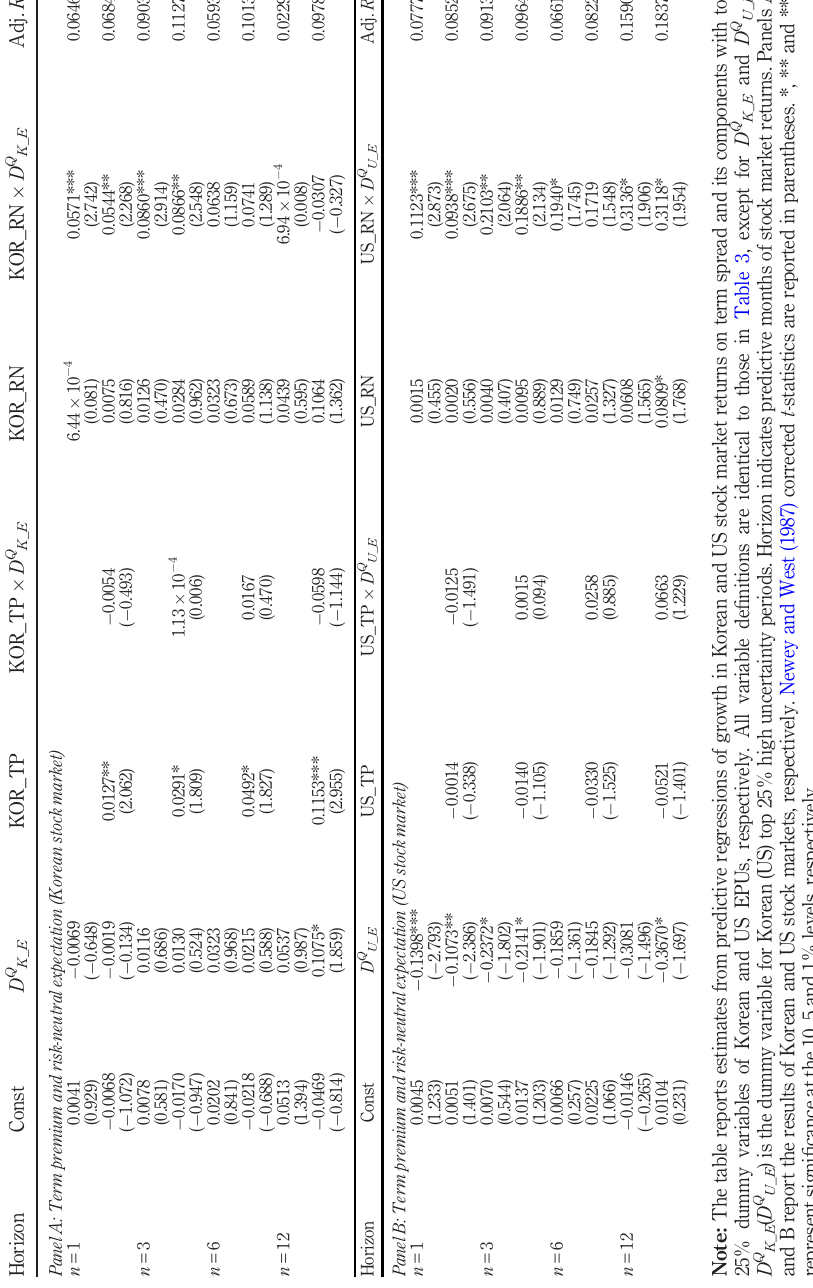
Table 10. Information of term spread and its components with uncertainty in Korean and US stock markets: top 25% uncertainty dummy